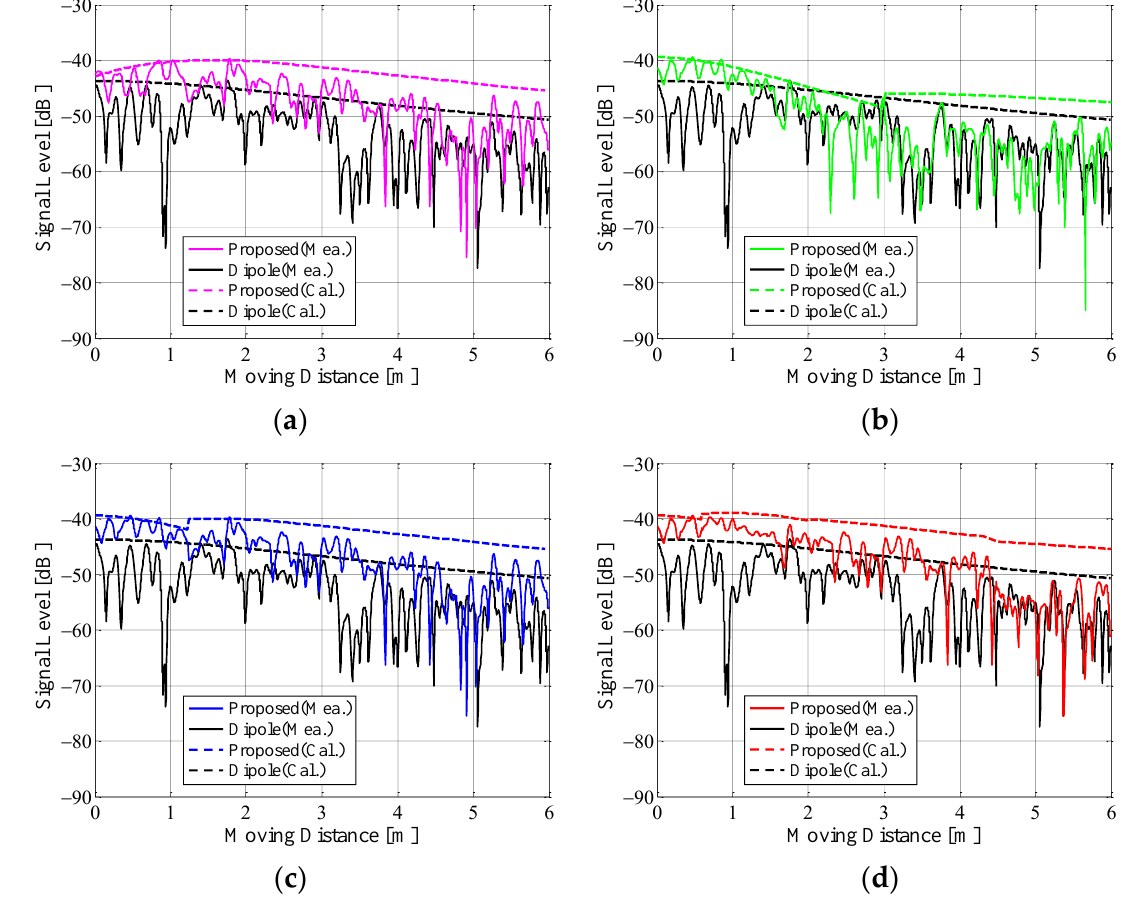
Figure 25. Instantaneous received signals of the proposed antenna: ( a ) 90° intervals from 0°; ( b ) 90° intervals from 45°; ( c ) 45° intervals; and ( d ) 22.5° intervals.